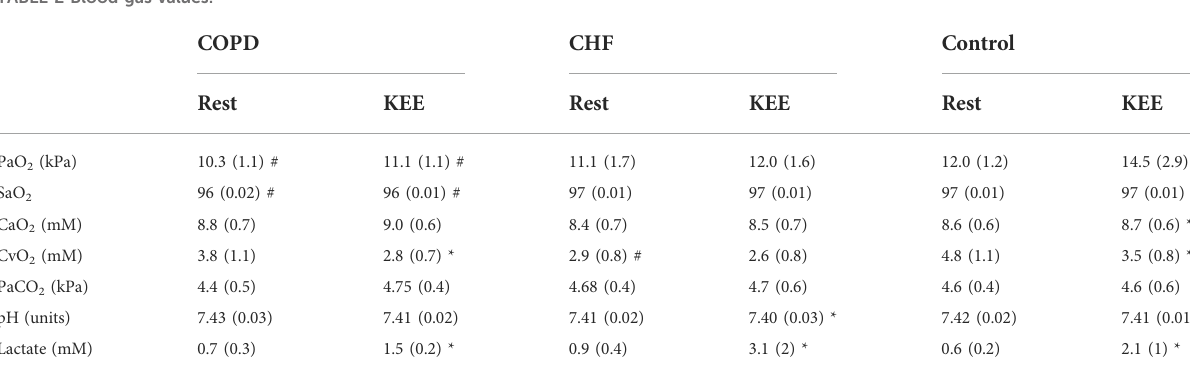
TABLE 2 Blood gas values. COPD CHF Control Rest KEE